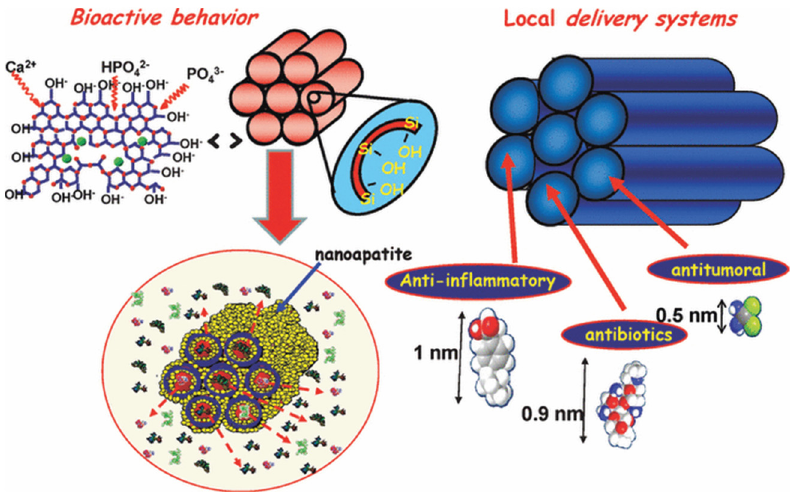
Figure 1. Summary of mesoporous bioactive glass (MBG) properties that make these materials highly attractive for biotechnological and biomedical applications [20]. attractive for biotechnological and biomedical applications